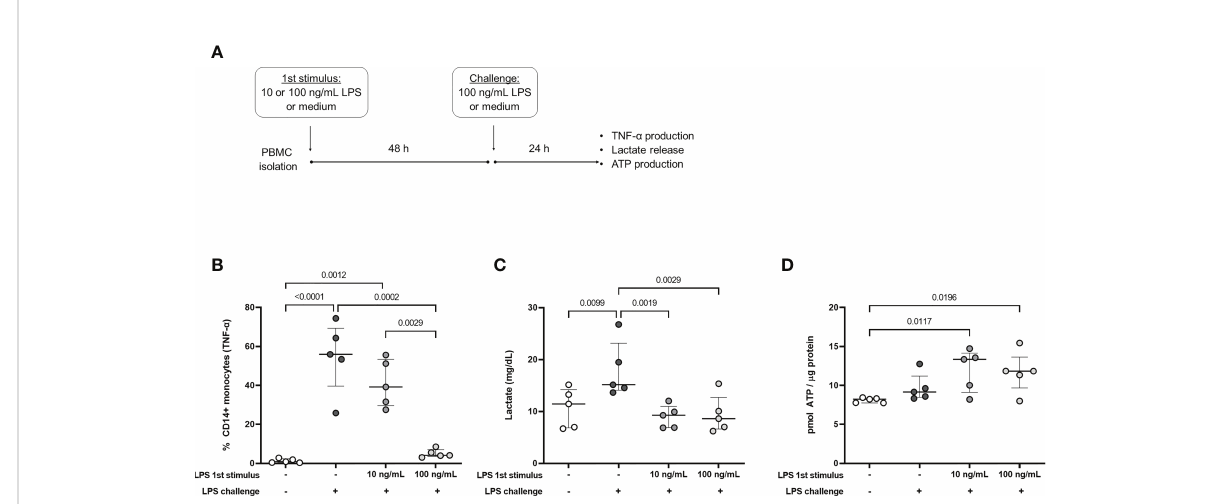
FIGURE 3 TNF- a production and metabolic pro fi le of endotoxin tolerant PBMCs. (A) : PBMCs were incubated for 48h (1st stimulus) with medium (-) or different concentrations of LPS and challenged with 100 ng/mL LPS (+) or medium (-) for 24h. (B) : Percentage of CD14 + monocytes producing TNF- a , measured by fl ow cytometry. (C) : Lactate concentration in culture supernatants. (D) : Intracellular ATP production. Graphs show mean and SD and each dot represents one individual donor evaluated in all experimental conditions (n = 5 donors); p-values indicate differences between each condition as measured by repeated measures one-way ANOVA followed by Bonferroni